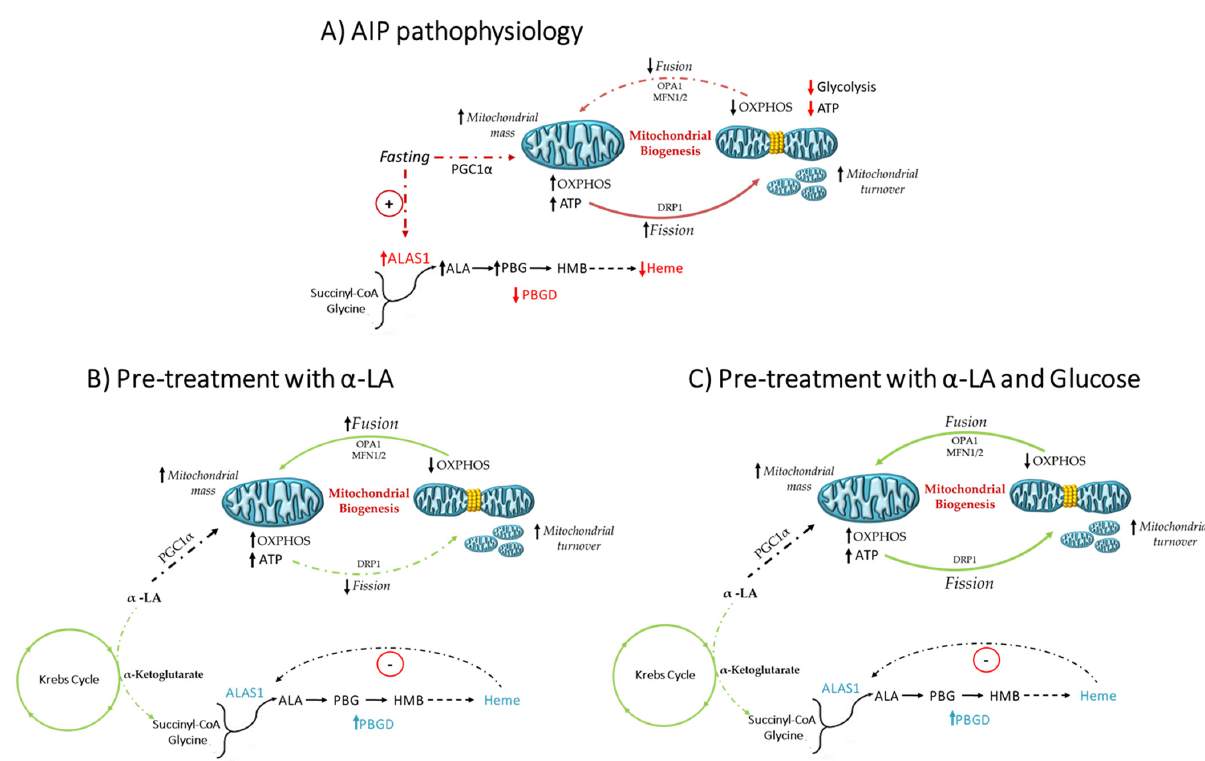
Figure 4. Schematic representation of metabolic alterations and the efficacy of α -LA in siPBGD cells during fasting. ( A ) Fasting induced mitochondrial biogenesis through PGC1 α , possibly worsening mitochondrial injury by shunting mitochondrial dynamics toward fission, which was mediated by DRP1, and inhibiting OPA1 and MFN2, which provide the fusion of mitochondrial inner and outer membranes. The accumulation of divided mitochondria lowered OXPHOS ability and exacerbated ATP shortfall. ( B ) Pre-treatment with α -LA in siPBGD cells even promoted PGC1 α activity, but it improved OPA1 and MFN2 expression, thereby enhancing mitochondrial fusion, which is a condition that could support OXPHOS activity during energy demand. ( C ) Pre-treatment with α -LA and glucose may recover the overall mitochondrial wellness by acting at multiple levels. On one hand, α -LA may improve heme biosynthesis, which is a mechanism occurring in the mitochondrial matrix. On the other hand, α -LA may enhance glycolysis, ATP production, and OXPHOS, possibly sustaining the Krebs cycle. The restoration of hepatocellular homeostasis could allow recovering mitochondrial dynamics, in terms of fusion, fission, and overall mitochondrial mass.